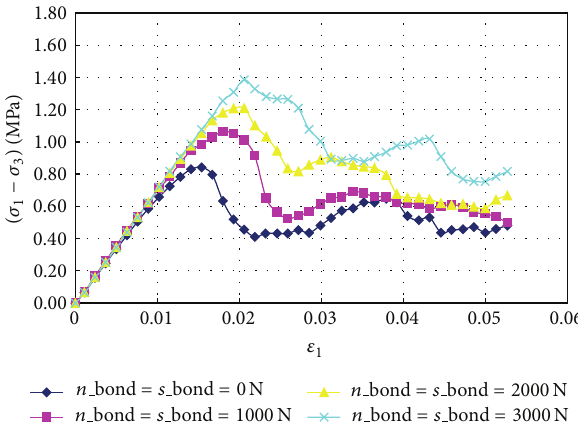
Figure 14: The biaxial compression curves with different debris bonding force.